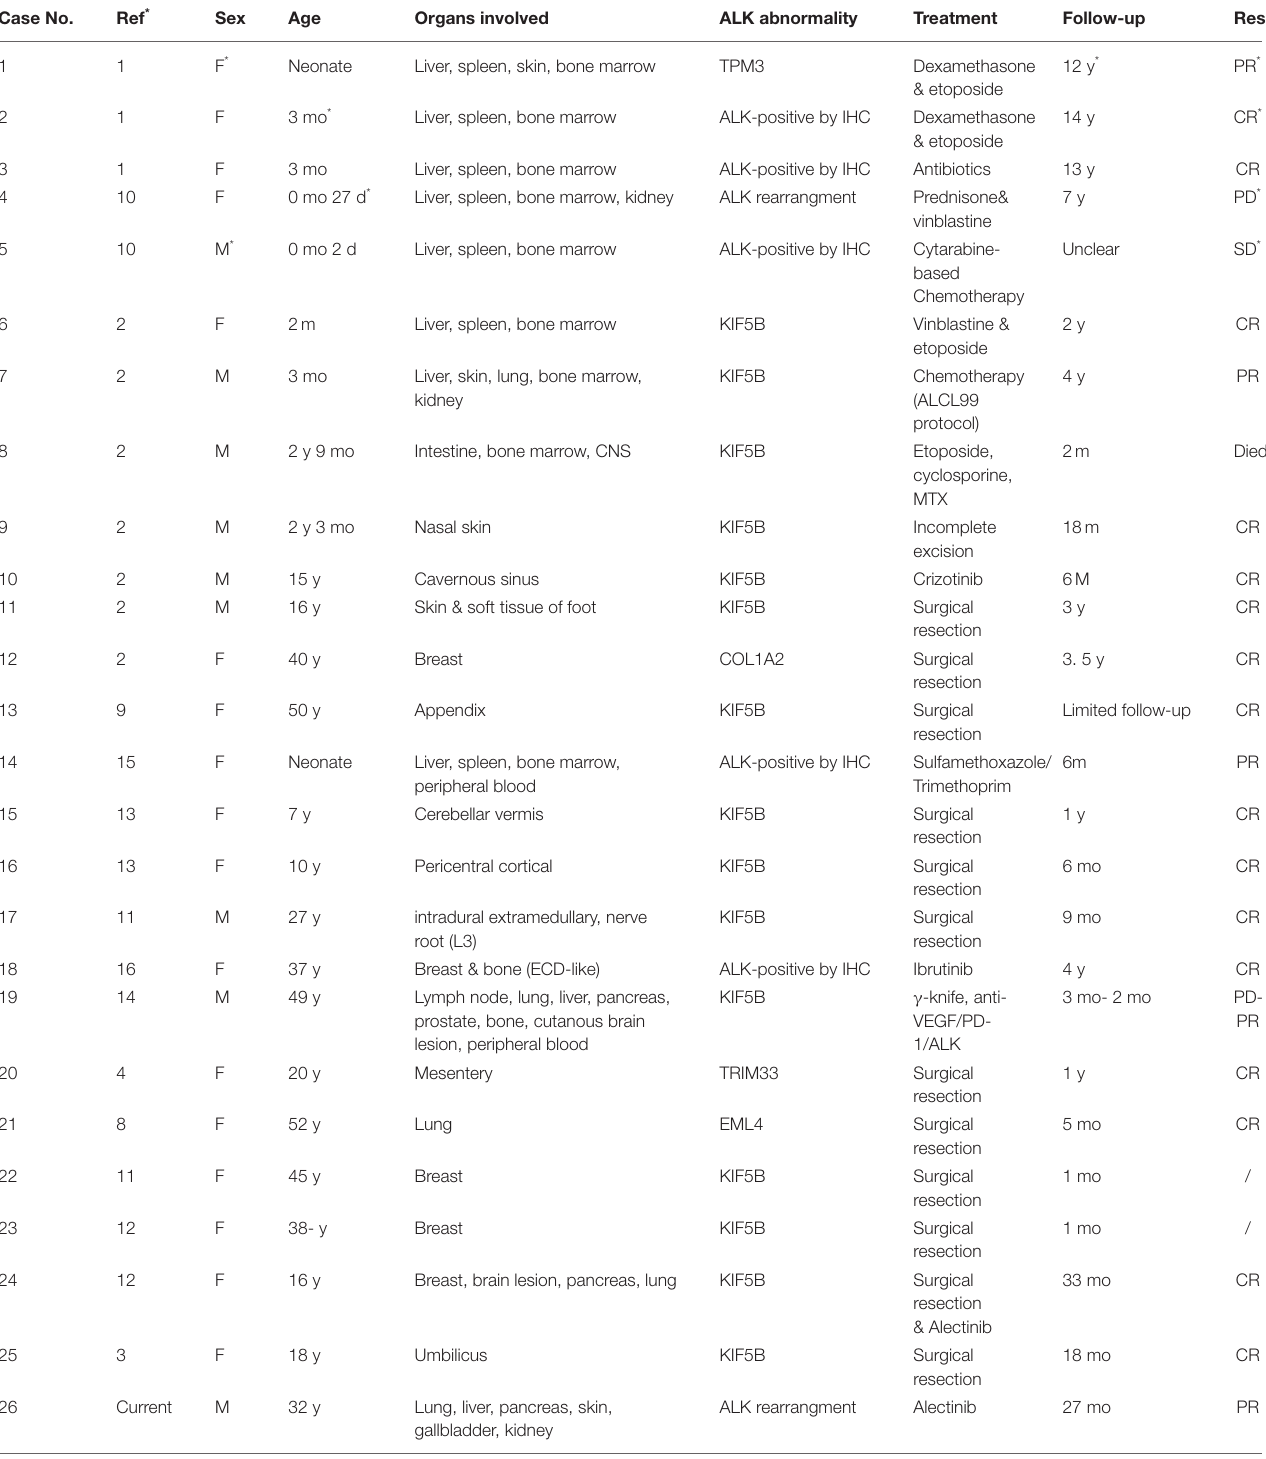
TABLE 2 | Summary of organ involvement, gene type, treatment and response for patients with APH. Case No. ALK abnormality Treatment Follow-up Res.